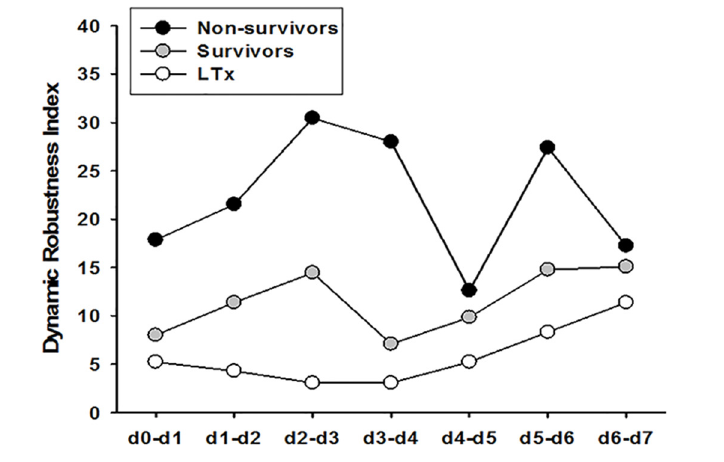
Figure 4. Dynamic robustness index in PALF. Circulating inflammatory mediators in serum samples from PALF patients were measured. DyNA (stringency levels = 0.7 and 0.95) was performed during seven time frames, d 0–1, d 1–2, d 2–3, d 3–4, d 4–5, d 5–6, d 6–7, and the dynamic robustness index for each patient group (survivors [n = 61 patients], nonsur- vivors [n = 12 patients], LTx recipients [n = 28 patients]) was calculated, as described in Materials and